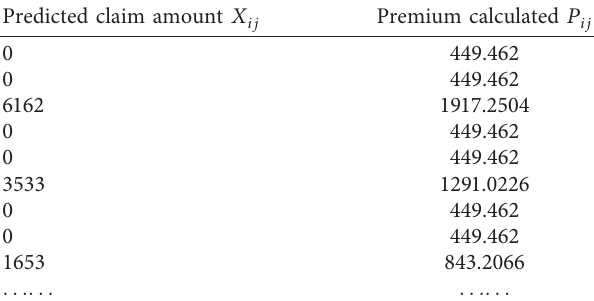
Table 3: Pure premiums for some